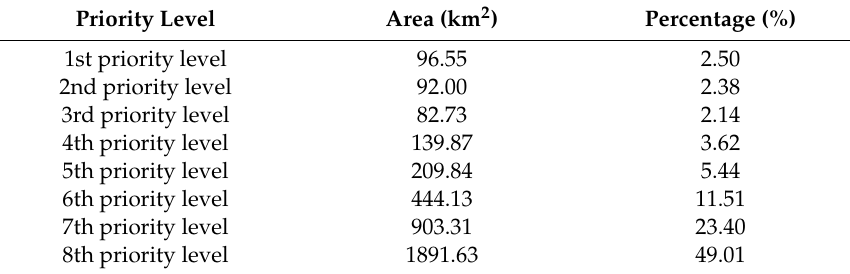
Figure 7. Conservation Priority levels of the Erer Sub-Basin. Table 10. Area of the conservation priority level of the study